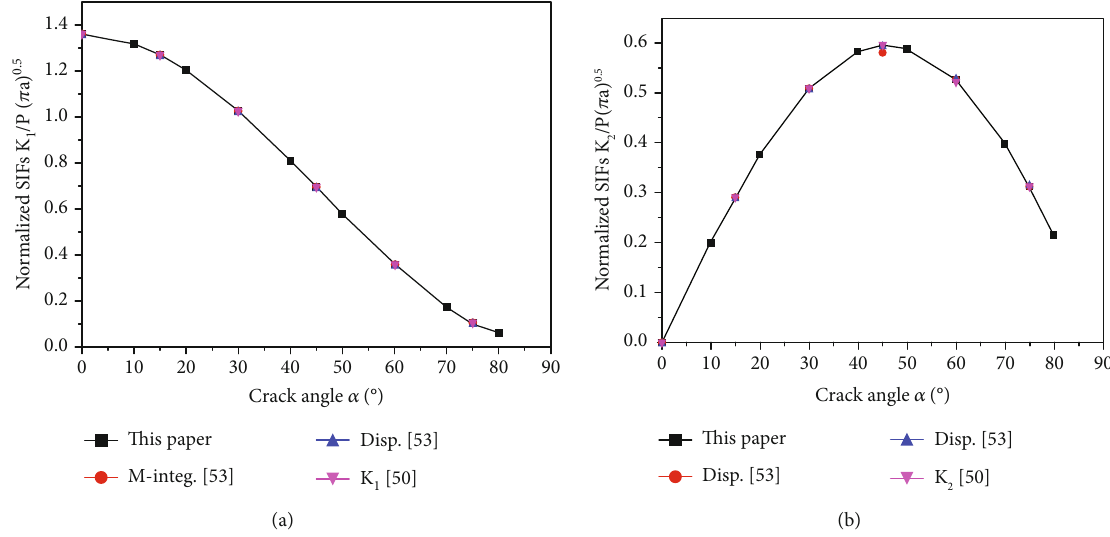
Figure 4: Normalized SIFs of angled crack in a homogeneous rectangular plate: (a) normalized SIFs K (b) normalized SIFs K / P ð π a Þ 0 : 5 at di ff erent crack 2